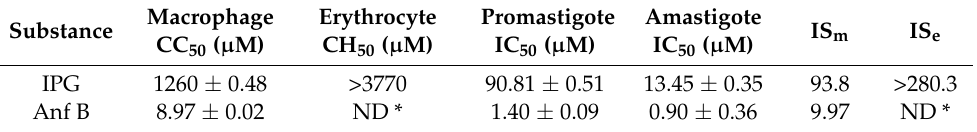
Table 4. In vitro antileishmanial activity, cytotoxicity, selectivity index.